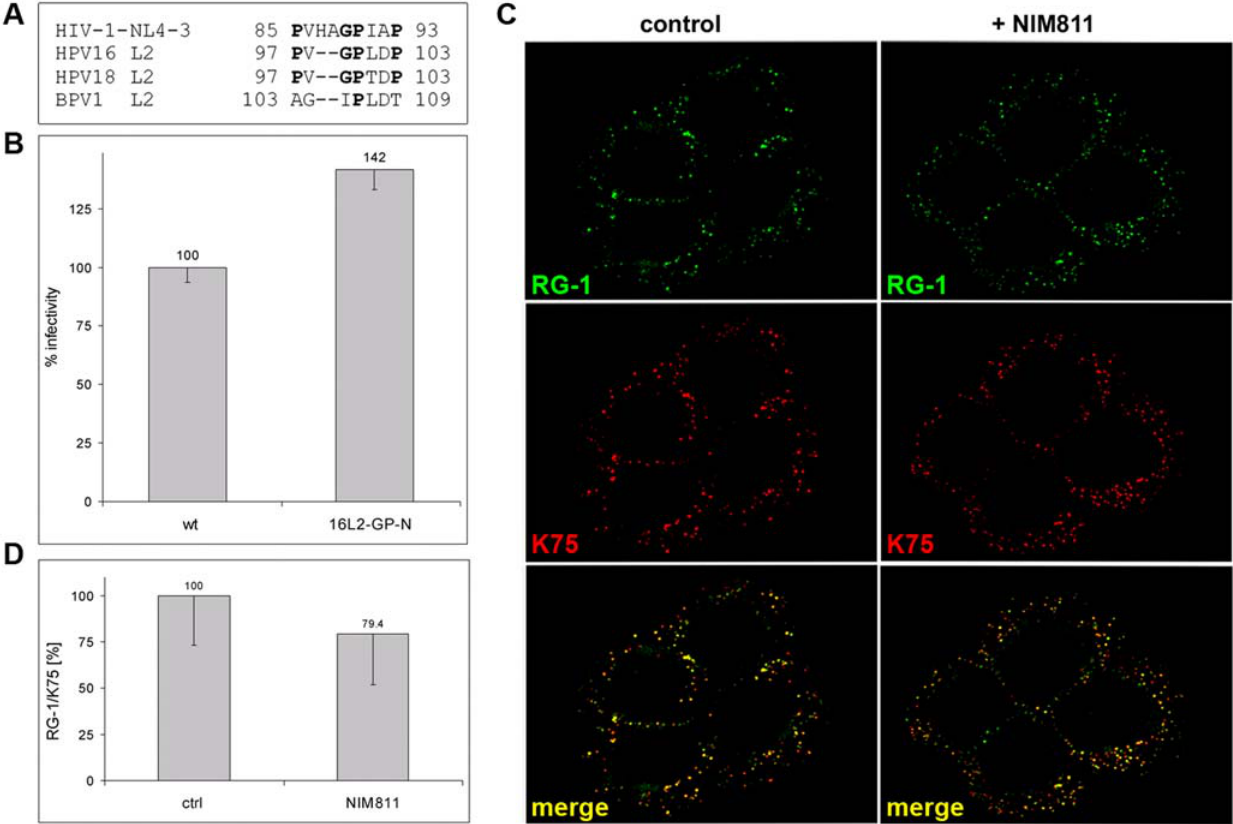
Figure 6. L2 protein is the likely target of CyPB. (A) Sequence alignment of selected PV L2 proteins with CyPA binding site of HIV capsid protein. (B) 293TT cells were infected with similar amounts of HPV16 wt and 16L2-GP-N mutant pseudovirus and scored at 72 hpi. The difference in infectivity is statistically significant (p , 0.01; n=5) based on testing two independent pseudovirus preparations. (C) 16L2-GP-N mutant pseudovirus was bound to HaCaT cells in presence or absence of NIM811 for 4 h at 37 u C and subsequently stained with RG-1 and K75. All images were taken with the same settings. (D) Quantification of RG-1 and K75 signal strength using randomly selected cells (n . 15).